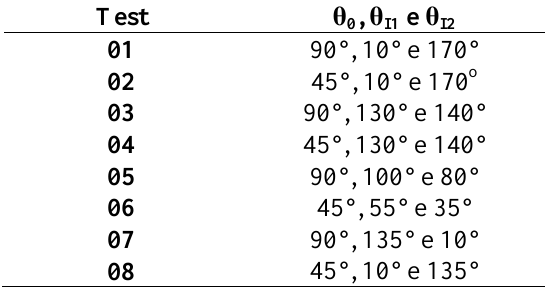
Table 3. Tests of the second application of GA-MMC